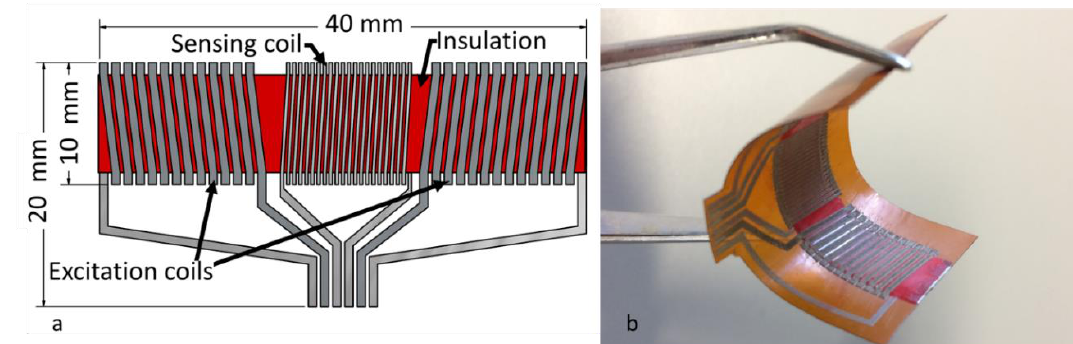
Figure 1. Fluxgate sensor: ( a ) Schematic representation of the conception of the sensor with dimensions; ( b ) Photographic view of the fabricated flexible sensor.